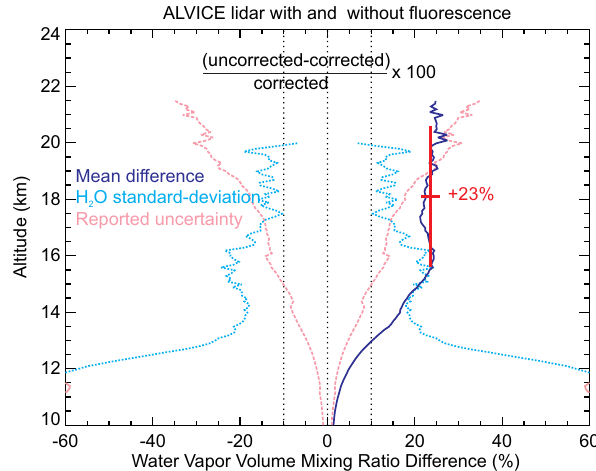
Fig. 6. Mixing ratio difference between the fluorescence-corrected and uncorrected ALVICE lidar profiles. The thick red vertical and horizontal lines indicate the 15–20km layer-averaged difference and standard deviation respectively. The measurements standard deviation and uncertainty are over-plotted in dotted cyan and dashed pink